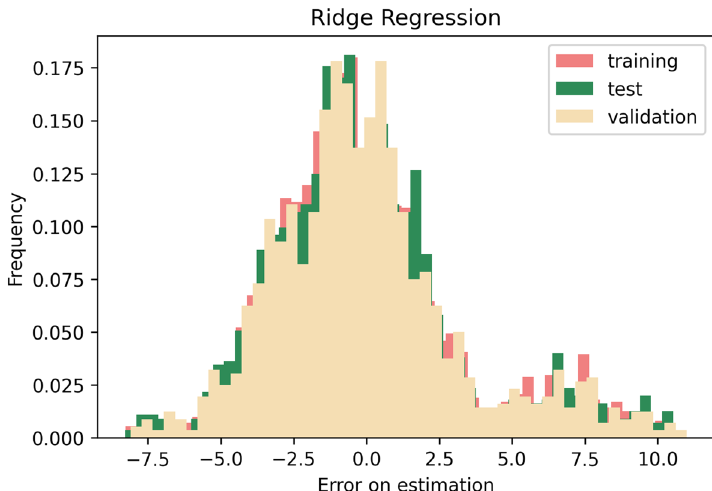
Fig. 21 Error histogram